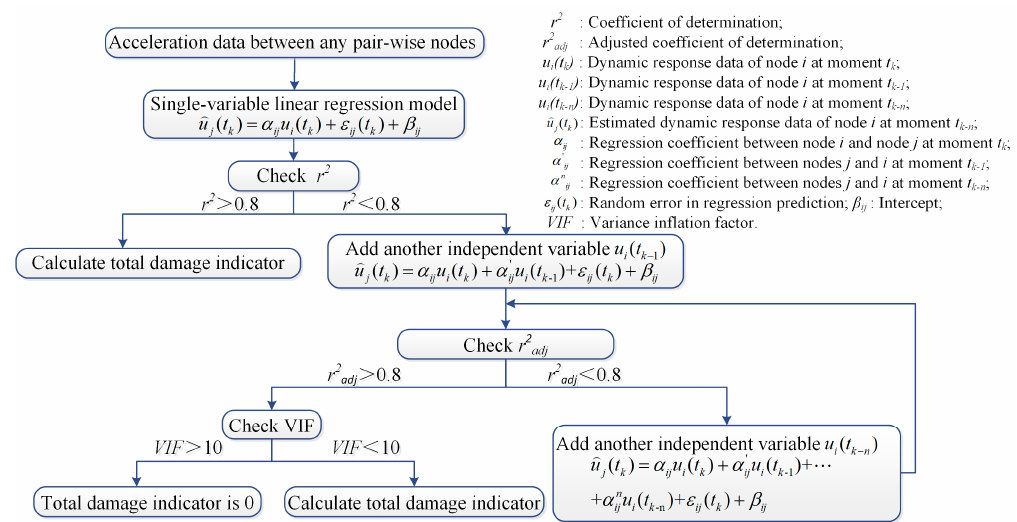
Figure 12. Flowchart of the regression model algorithm for local damage identification.